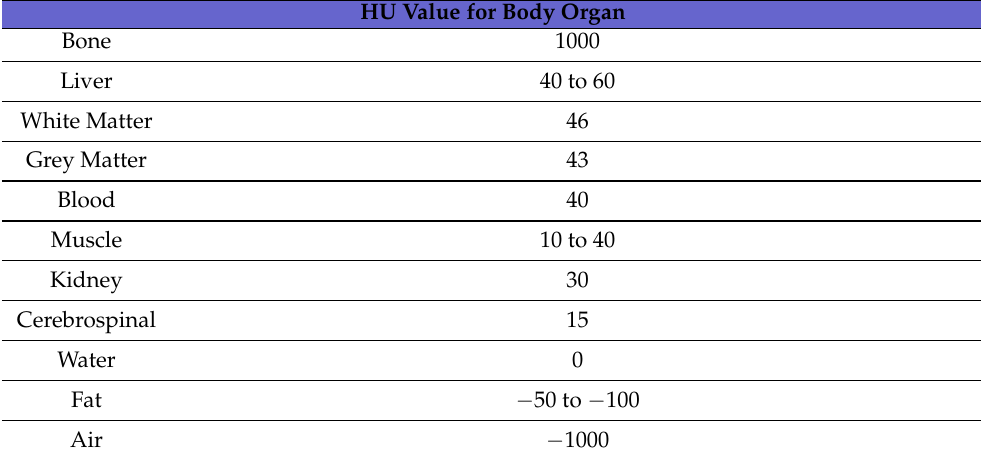
Table 1. Hounsfield unit values define for body organ.